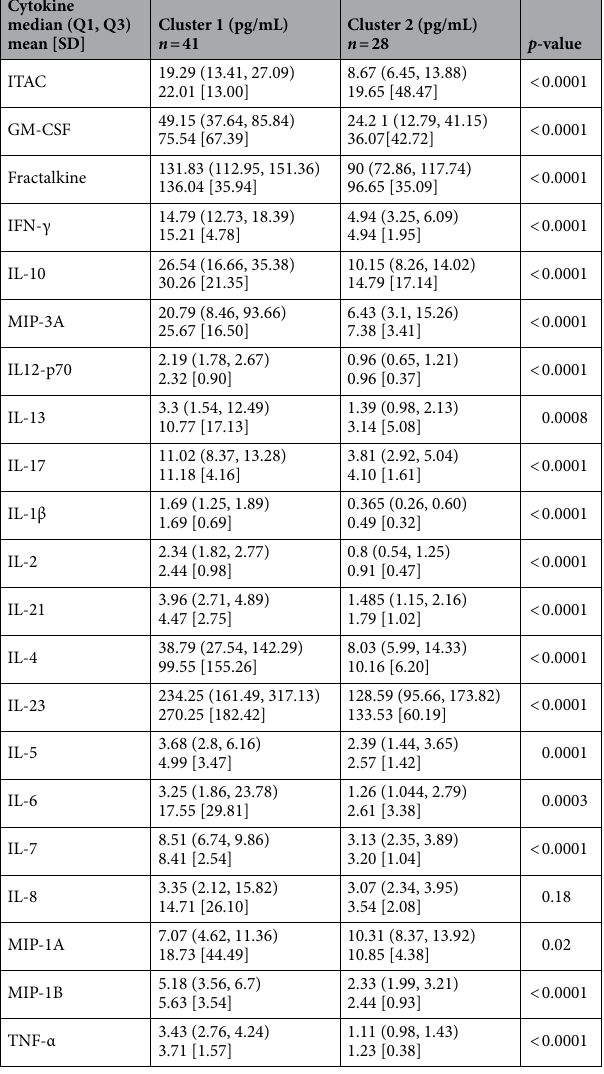
Table 2. Plasma cytokine